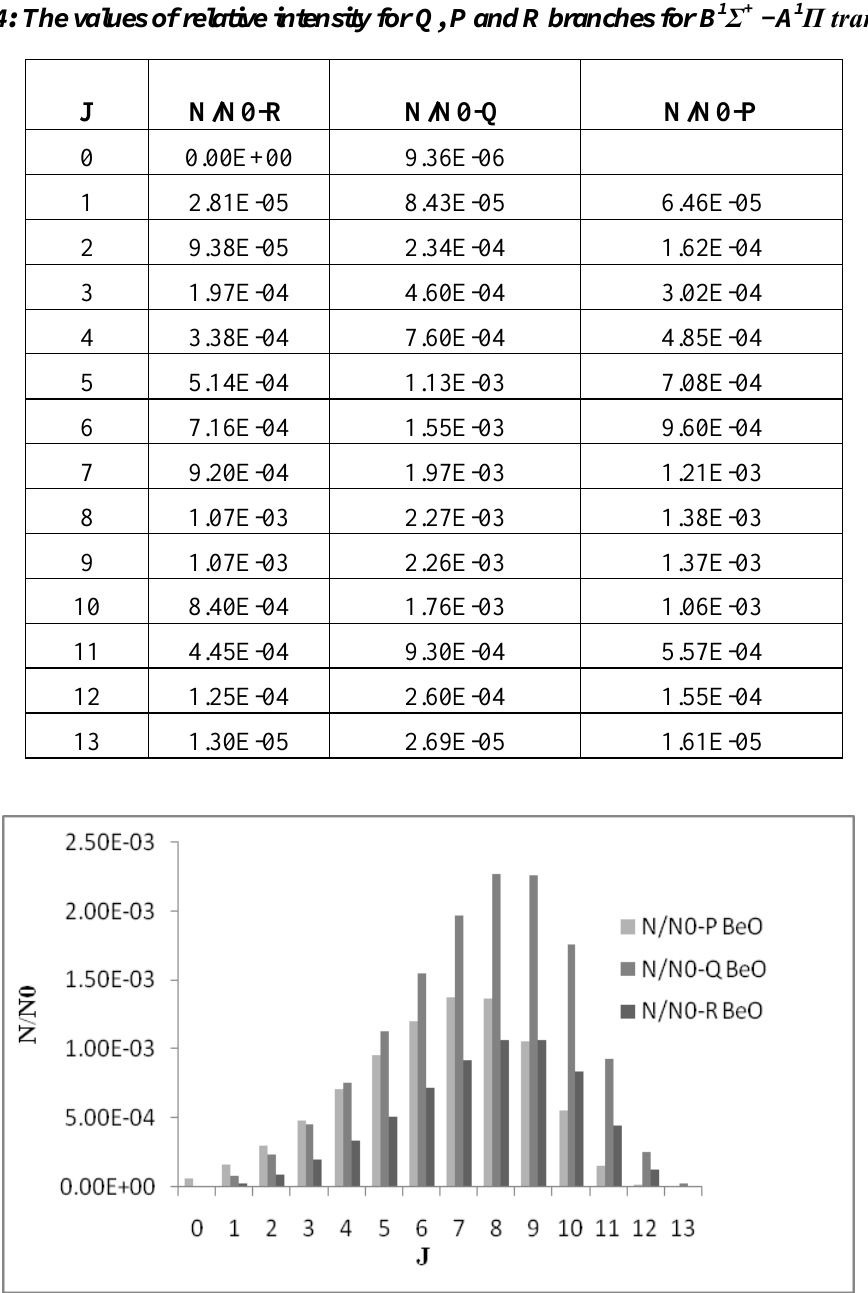
Fig.3: Relative population of B 1 Σ + - A 1 Π as a function of J for BeO molecule